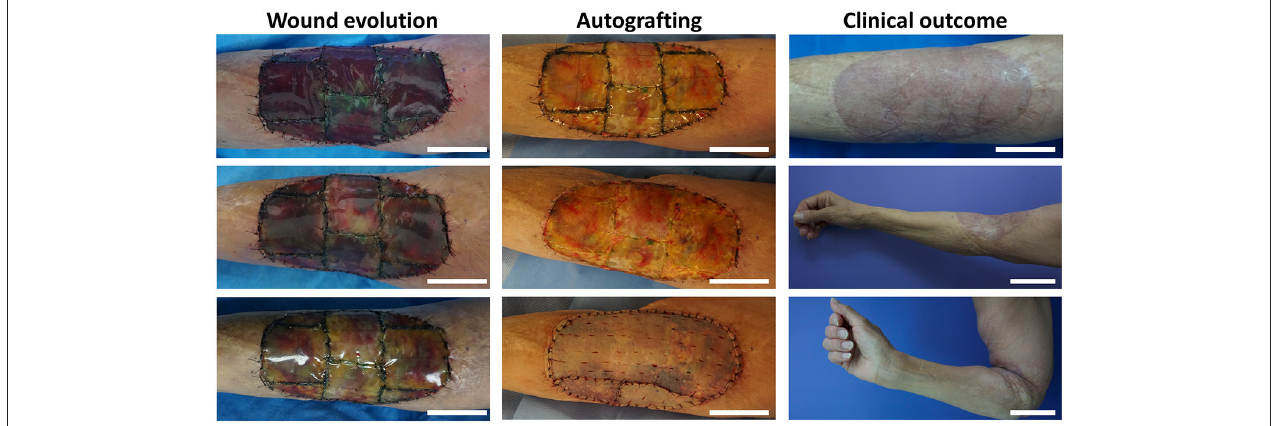
FIGURE 5 | Overall wound evolution, autografting procedure, and clinical outcome. As a representative example, wound evolution of P2 is shown for days 1, 7, and 13 (from top to bottom). Autologous split-thickness skin graft was performed 21 days after scaffold implantation. Clinical outcome and functional recovery of the wound at day 90 post implantation are shown. Scale bars represent 5cm except for Clinical outcome, middle and bottom, which represent 10cm.